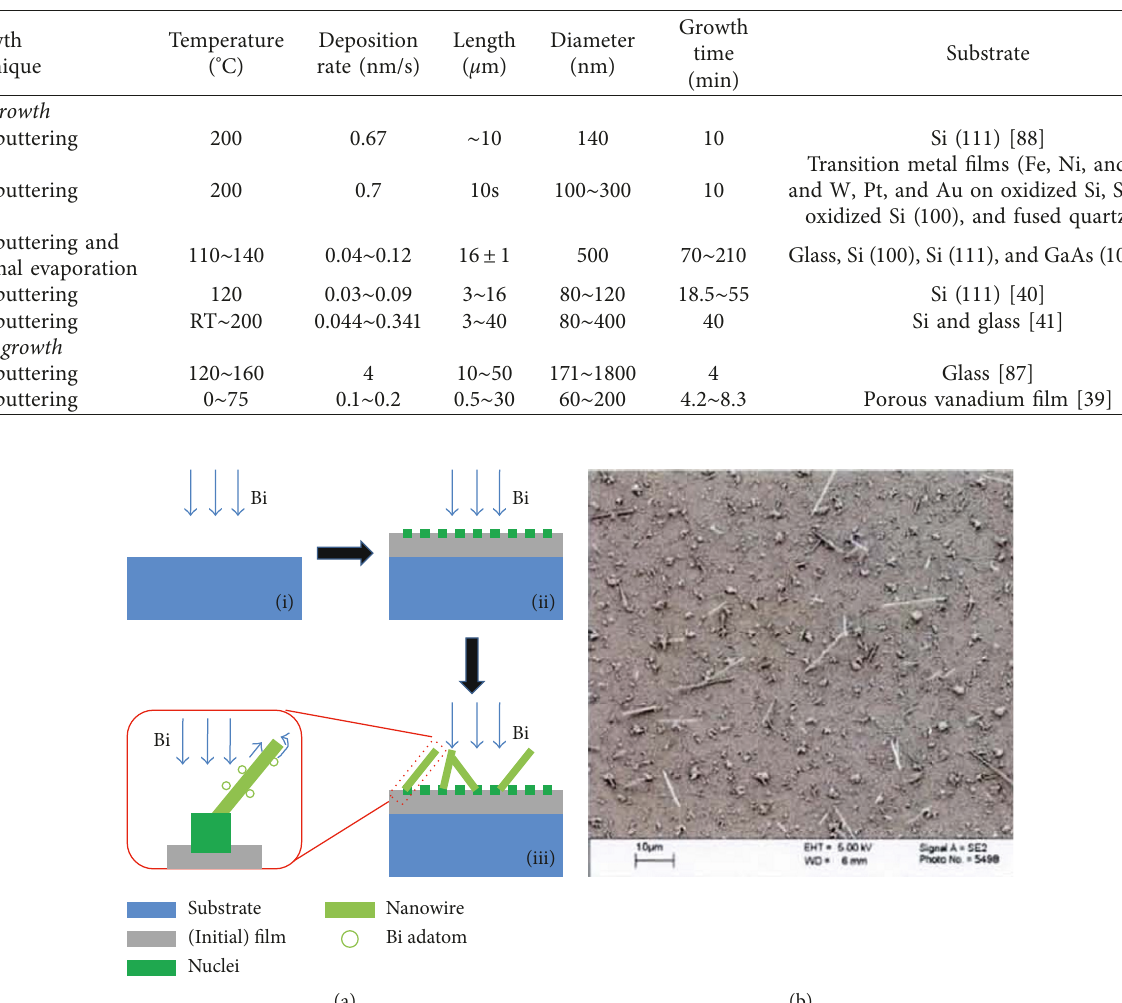
Table 1: The direct growth of Bi nanowires by PVD